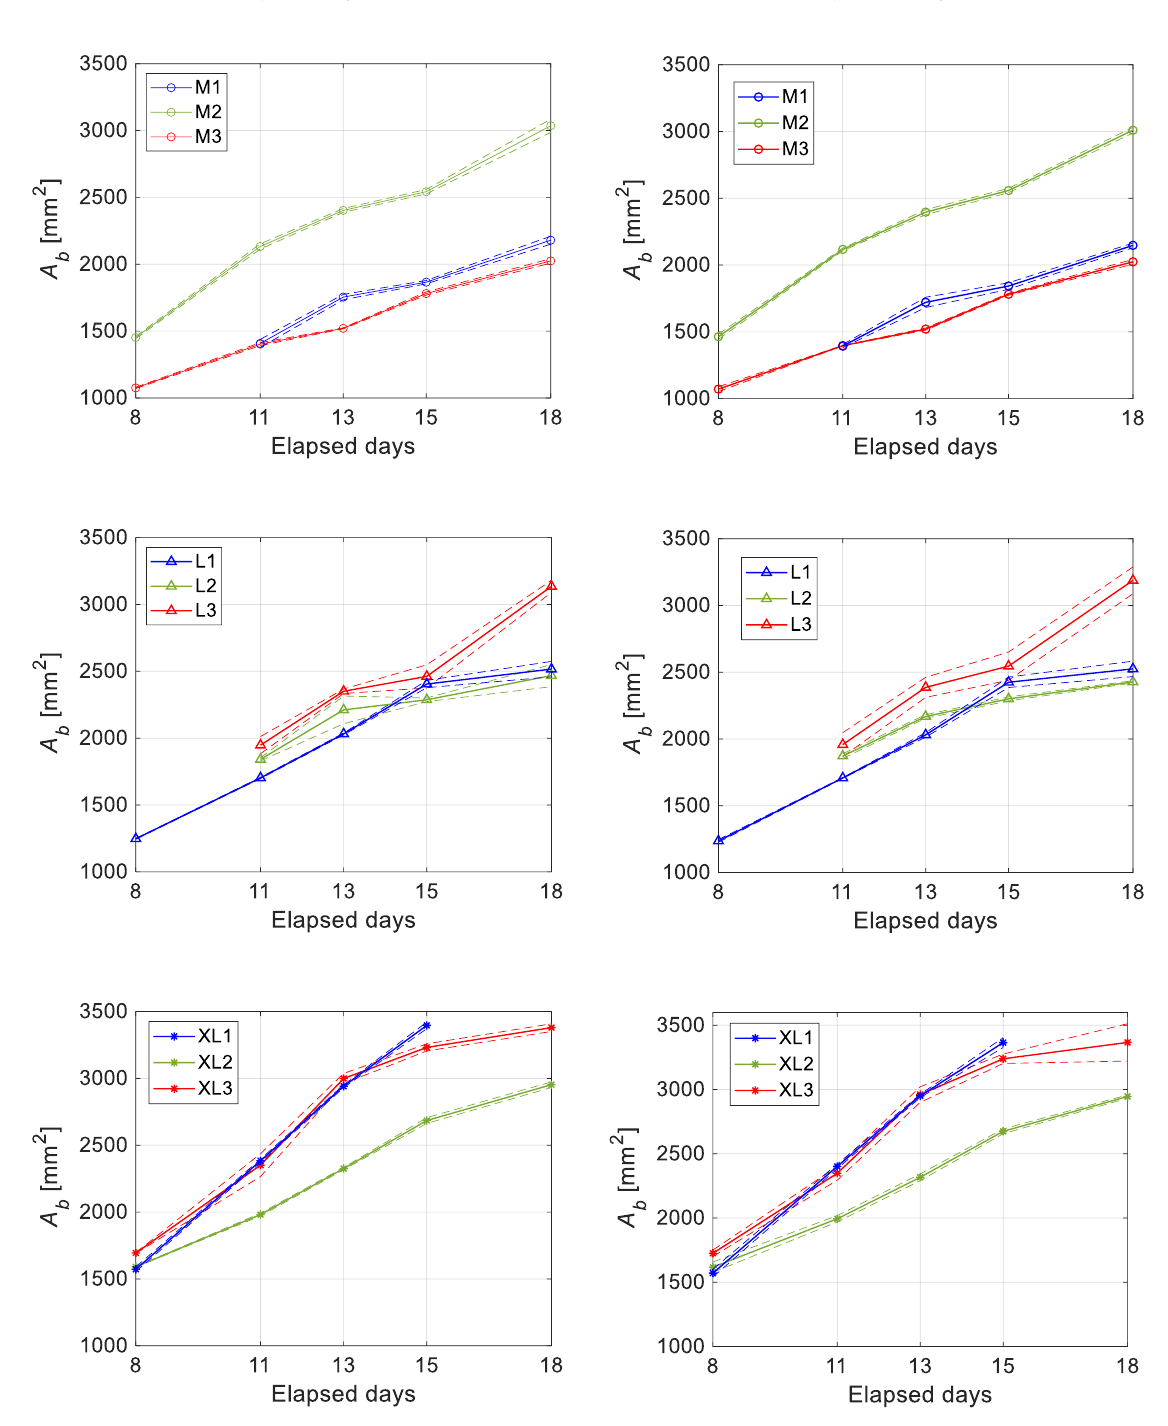
Figure 9. Daily mean value, estimated with a 68% confidence interval, for repeatability and repro- ducibility tests of the area of the air chamber for different egg categories (M, L,